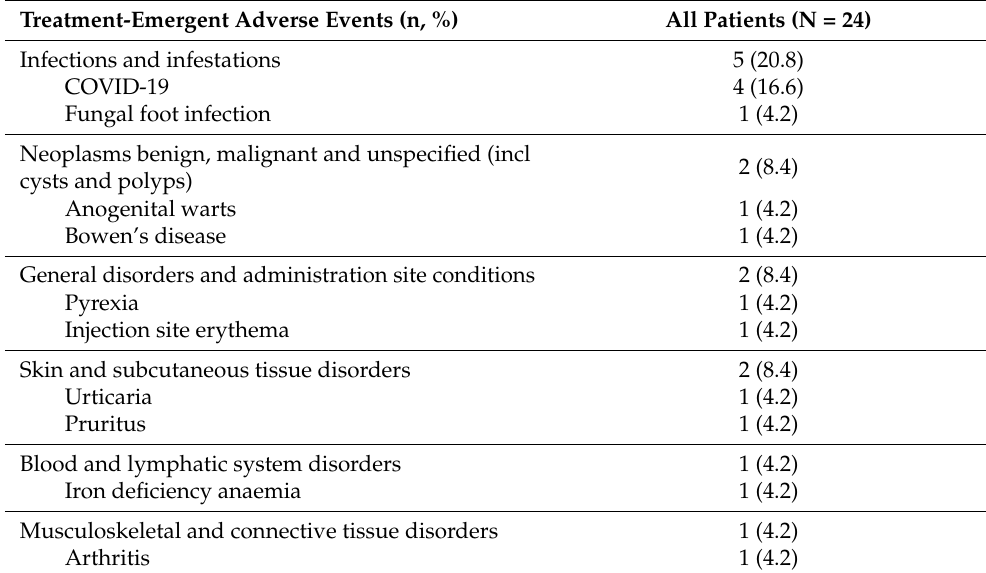
Figure 2. Proportion of patients in clinical remission, remission defined by fecal calprotectin (FC) < 250 µ g/g, and biochemical remission, defined as C-reactive protein (CRP) ≤ 5 mg/L and/or FC < 250 µ g/g, prior to transition to subcutaneous vedolizumab and after the transition. In total, 13 (54.2%) treatment-emergent adverse events (TEAE) were reported by 11 patients, and the most common TEAE was COVID-19 (Table 3). One patient reported injection site reaction (erythema around the injection site), and no serious adverse events were reported. Table 3. Incidence of treatment-emergent adverse events by system organ class and preferred